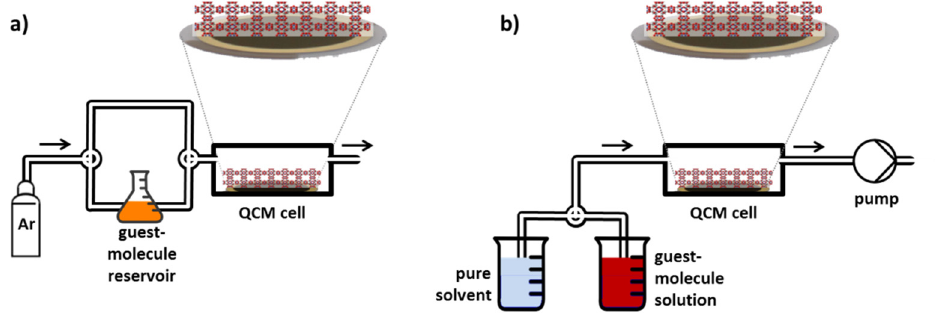
Figure 1. Setup of uptake experiments from gas and liquid phase. ( a ) A gas flow system where the carrier gas (here: argon) flows through the quartz crystal microbalance (QCM) cell, i.e. , over the QCM sensor, is used for uptake experiments from the gas phase. The carrier gas flow can be enriched with the vapor of the guest molecules by passing through (or over) the reservoir of the guest molecules; ( b ) The uptake of guest molecules from the liquid phase can be investigated by the same sample by connecting the QCM cell to a peristaltic pump, so that either the pure solvent or the guest-molecule solution can be pumped through the QCM cell. Switching from the pure gas flow, or pure solvent, to the enriched gas flow, or solution, results in the uptake of the guest molecules by the surface-mounted metal-organic framework (SURMOF). The mass changes are recorded by